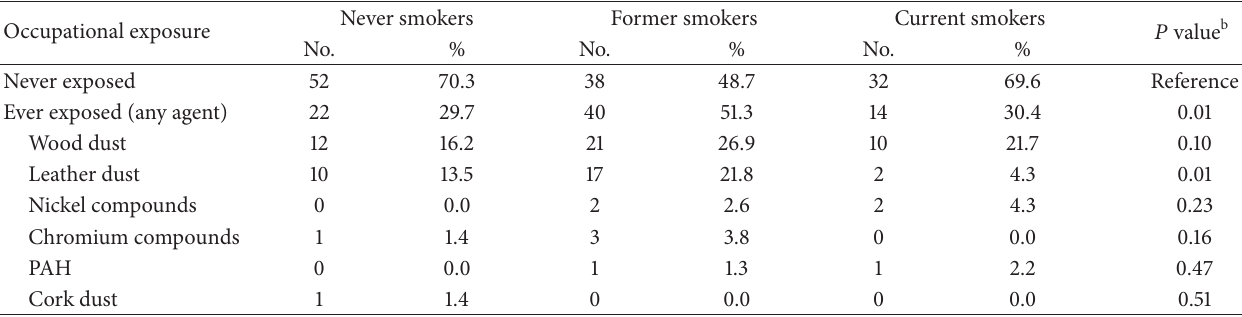
Table 4: Occupational exposure to carcinogenic agents among subjects with sinonasal cancer, by smoking status a ; Lombardy region sinonasal cancer registry, 2008–2011 ( 𝑁 = 200 with interview).